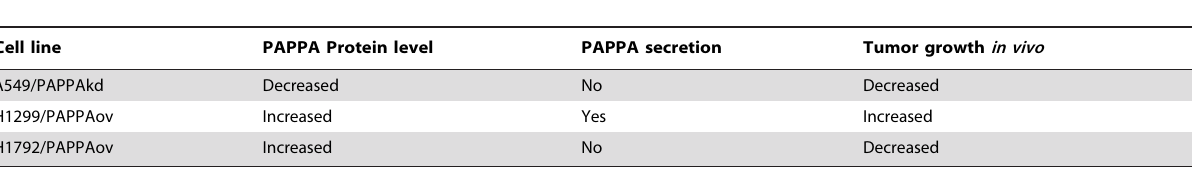
Table 1. Summary of PAPPA over-expression and down-regulation experiments.